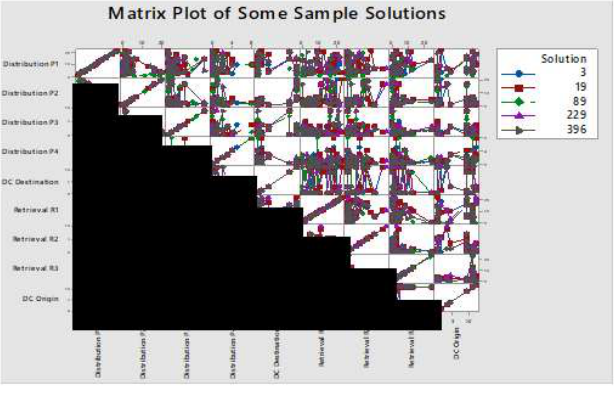
Fig. 7. Pairwise comparison between solution 3, 19, 89, 229, and